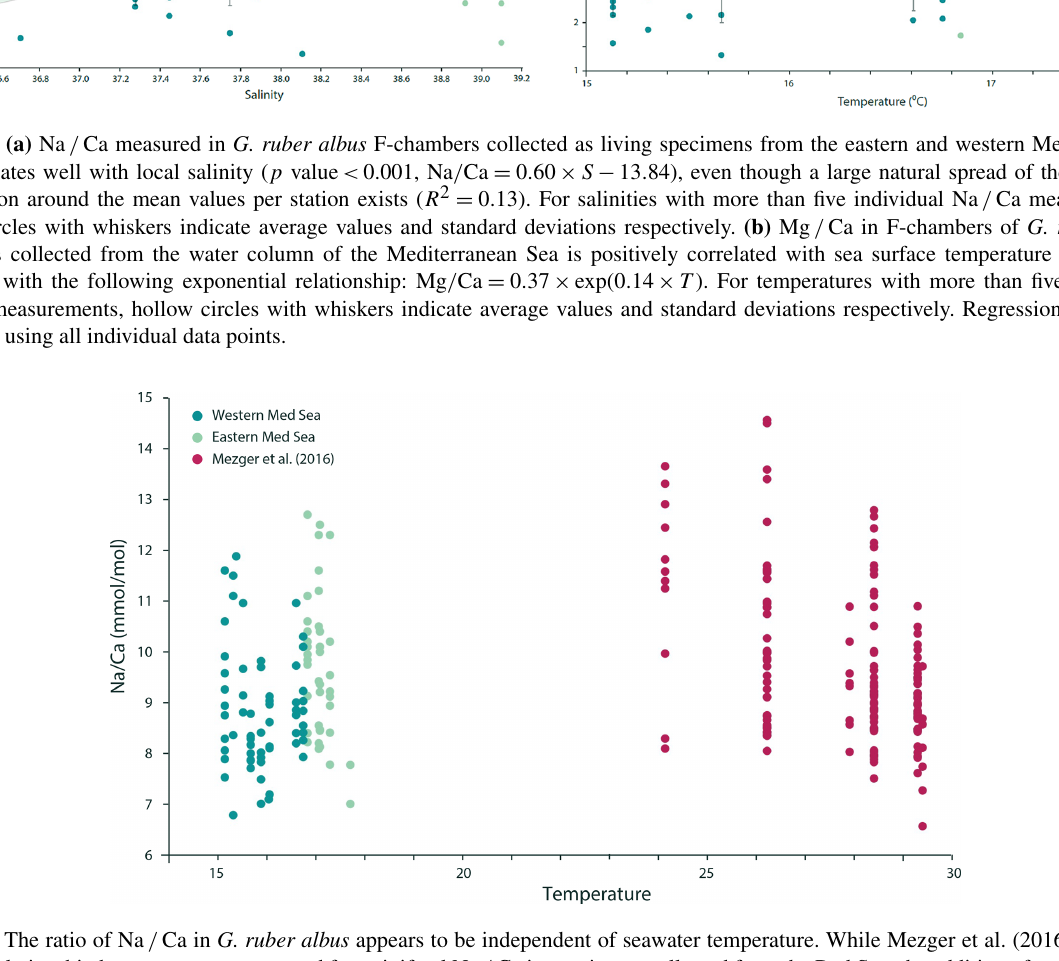
ment is an underestimation of salinity by 0.46 salinity